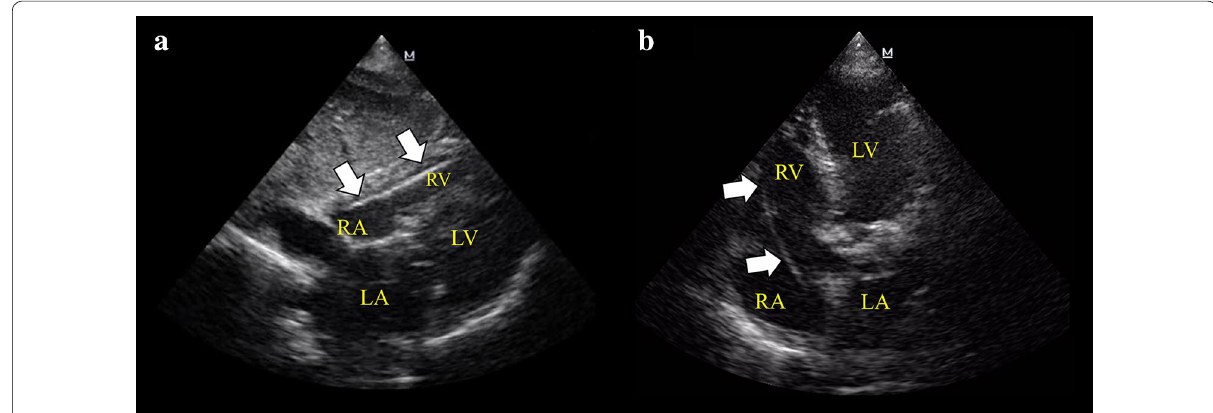
Fig. 1 Subcostal 4-chamber view ( a ) and apical 4-chamber view ( b ) demonstrating the temporary pacing electrode catheter (EC, arrows) into the right ventricle (RV). RV right ventricle, RA right atrium, LV left ventricle, LA left atrium